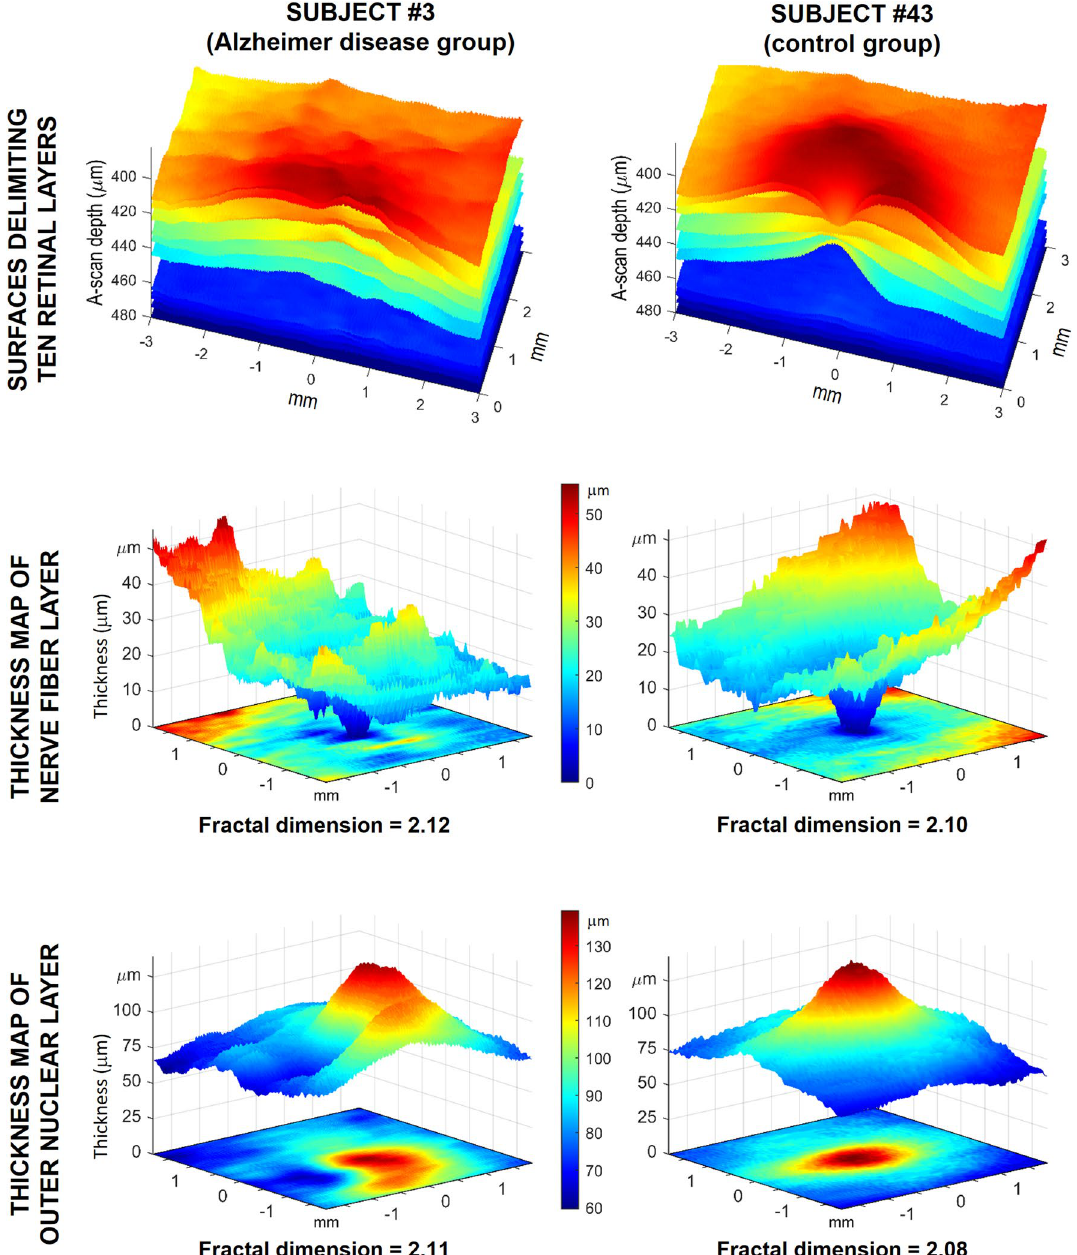
Figure 2. Roughness and fractal dimension of the retinal layers. Left column corresponds to the retina of a patient with Alzheimer’s disease (AD) (subject #3). The right column corresponds to the retina of a healthy participant (subject #43). The upper row shows the 11 surfaces delimiting the 10 retinal layers of both participants, clearly showing the greater roughness of the delimiting surfaces for the patient with AD. The middle and bottom rows show the thickness maps of the nerve fiber layer and the outer nuclear layers for the two subjects. Each thickness map is represented in two similar manners in the same figure: as a color-coded image at the foot of each figure and as a relief surface (or terrain elevation map) above. In the color-coded images, the roughness is visually demonstrated as texture or granularity. In the relief representations, the roughness is expressed by surface irregularities. Both representations lead to the conclusion that the roughness was greater for the patient with AD. The fractal dimension of each thickness map is a real number (slightly greater than 2) whose value reflects the roughness of each thickness map. Its higher value in both layers of the patient with AD indicates that their roughness is greater than that of the control participant, which agrees with the visual information. Image created using MATLAB (2018a) www. mathw orks. com/ produ cts/